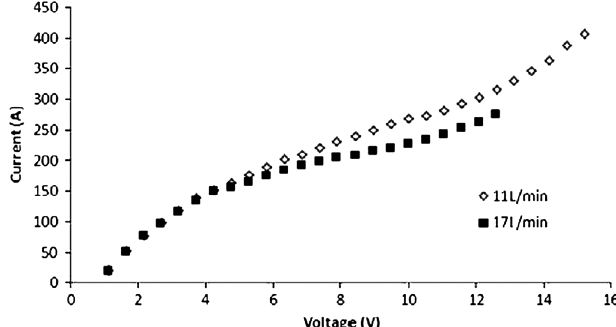
FIG. 19. Influence of acid flow on I(V) curve for nine-cell cavities. Higher flow makes the diffusion plateau more visible. Oxygen should be generated for voltage above 10